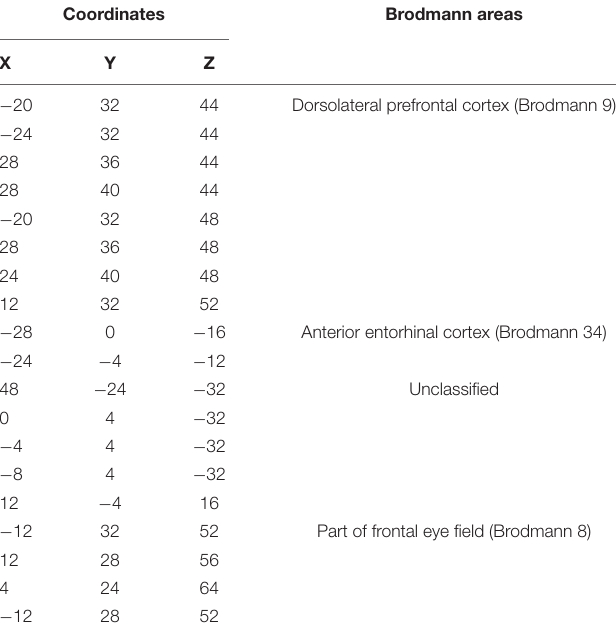
TABLE 2 | White matter brain areas with significant differences from the PDH group and control group based on JHU-White Matter atlas.